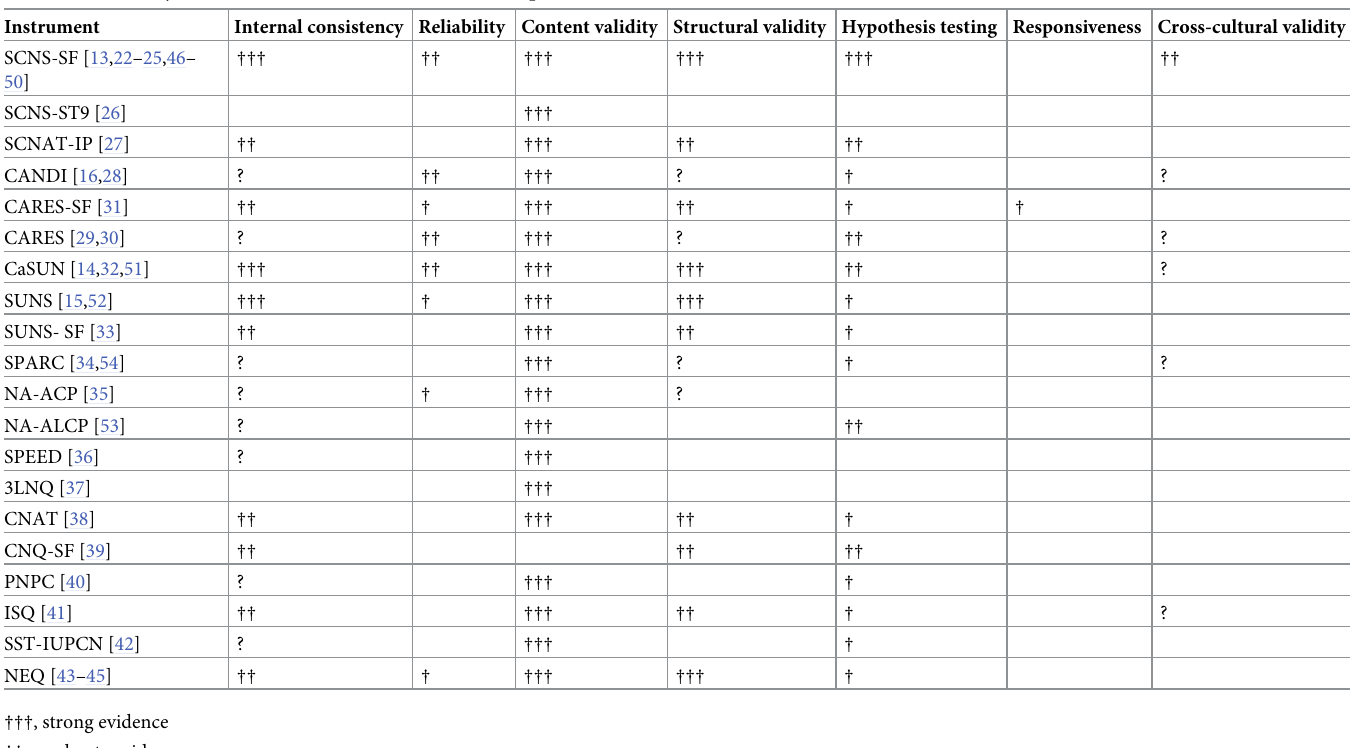
Table 4. Evidence synthesis of needs assessment tools in cancer patients.